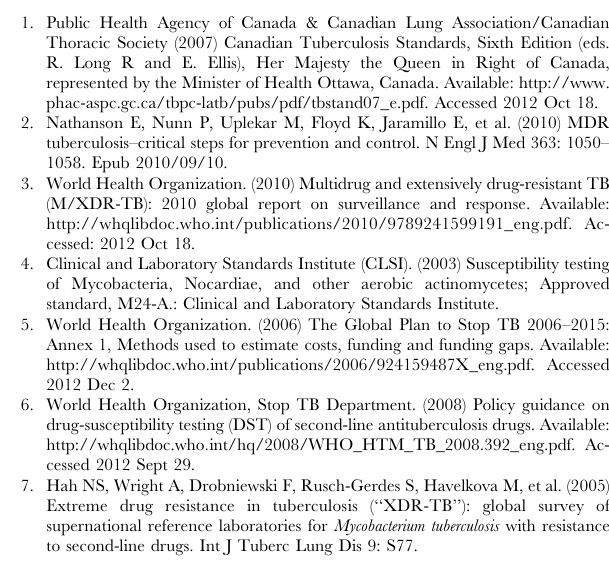
Table S1 Profile of Canadian-born MDR cases (n= 14). Table S2 Anti-tuberculous drug-susceptibility test re- sults of MDR tuberculosis case isolates, by disease type (new vs.